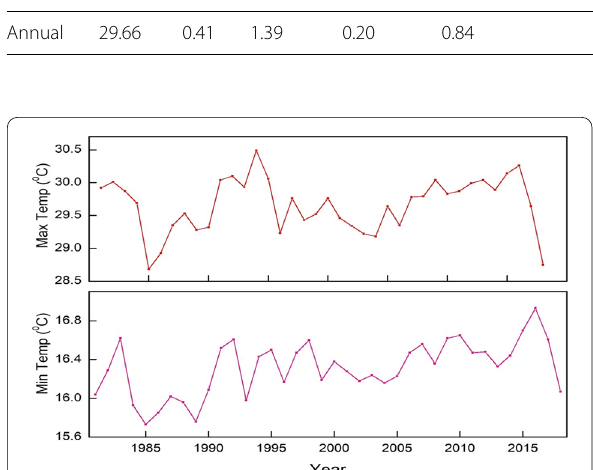
Fig. 10 Trends of annual mean Tmax and Tmin in semi-arid Borana